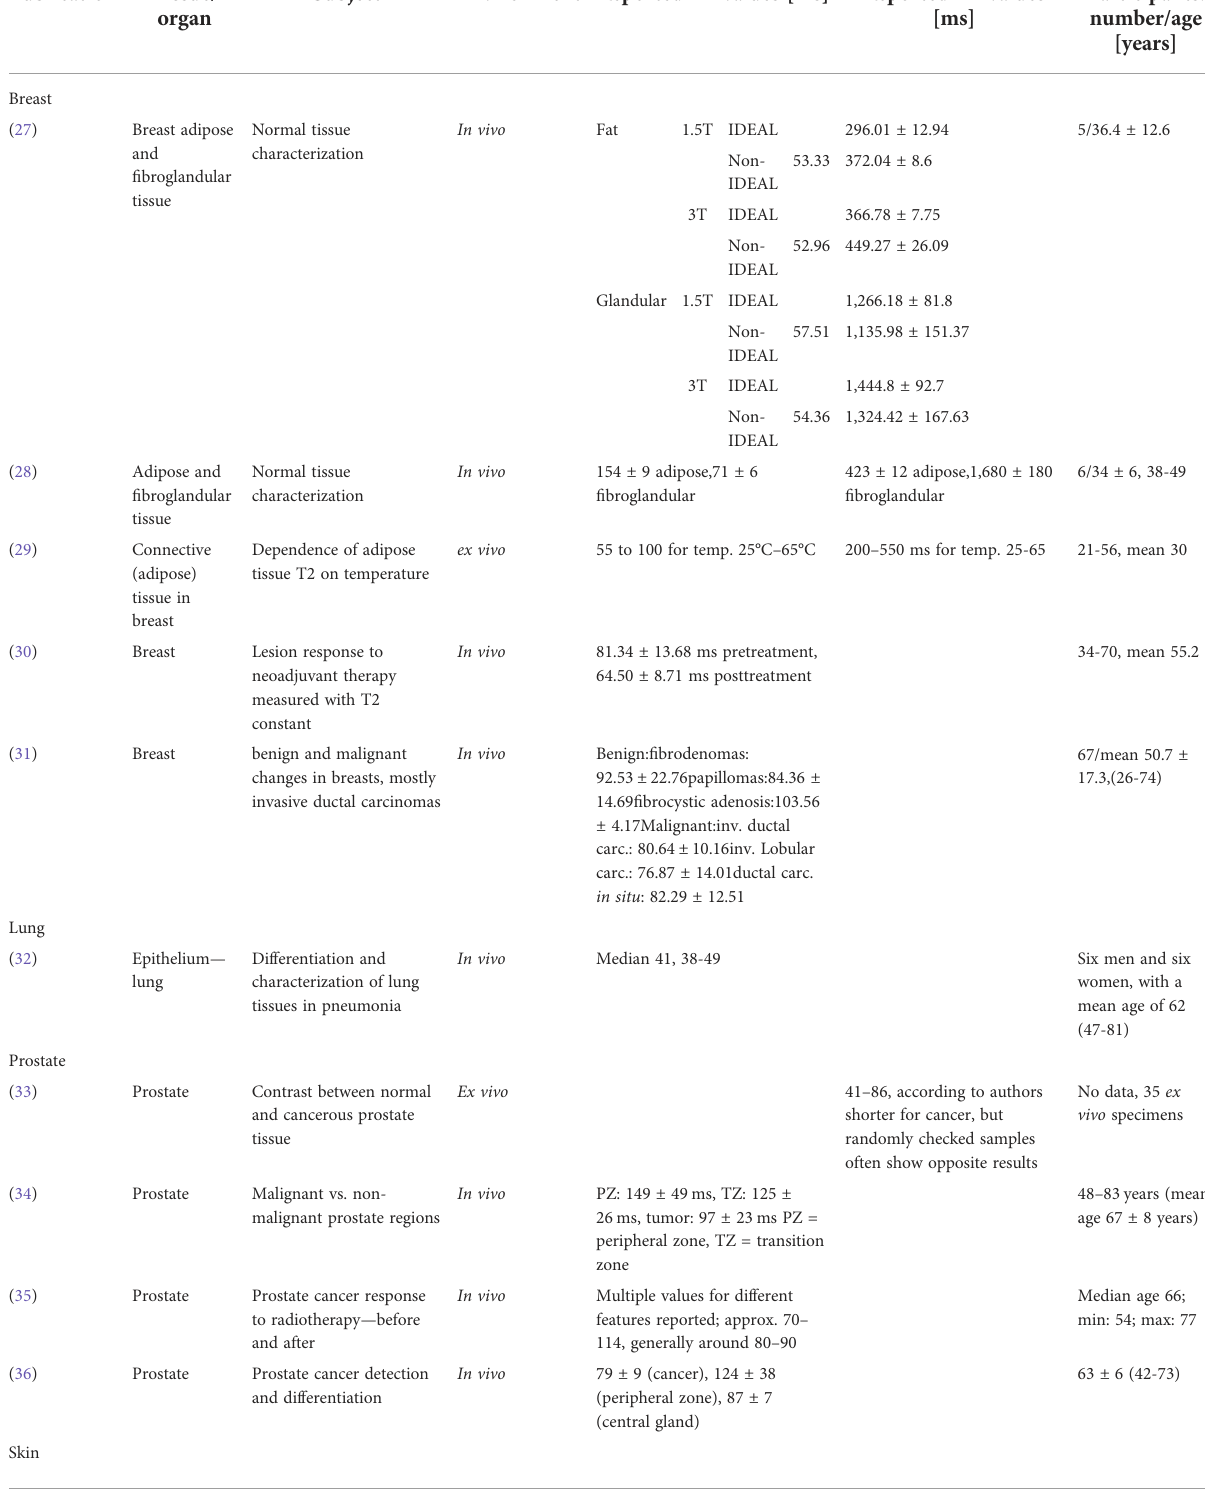
TABLE 4 Biomedical aspects of publications chosen for the detailed